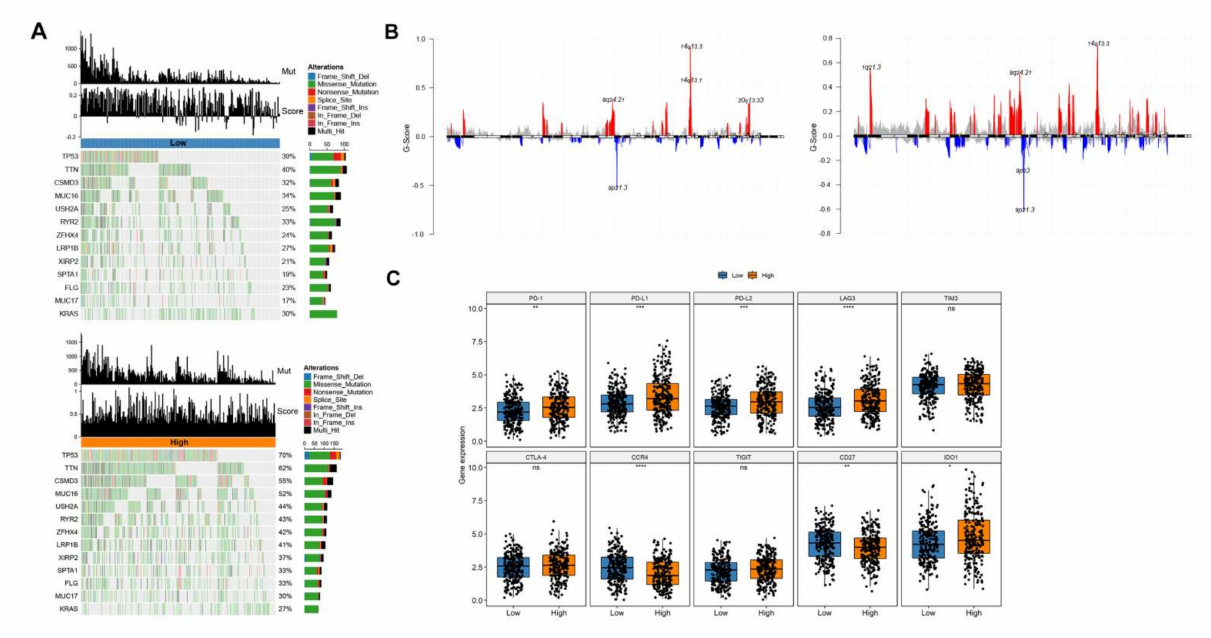
Figure 6. Other characteristics between the high and low score groups. ( A ) Genetic mutations in low ( up ) and high ( down ) risk groups. ( B ) CNV profiles in low ( left ) and high ( right ) risk group samples. ( C ) Gene expression of immune checkpoints between high and low risk